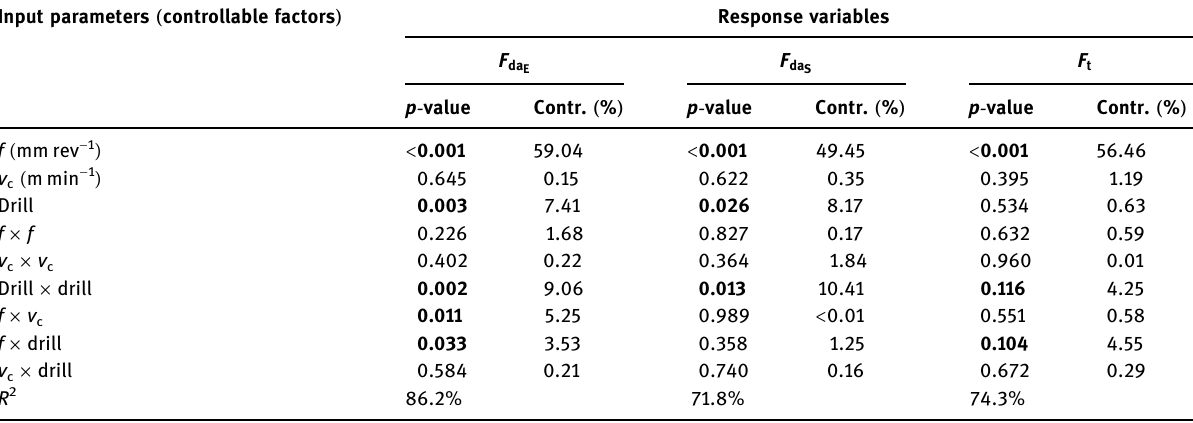
Table 5: ANOVA of the response variables Input parameters ( controllable factors